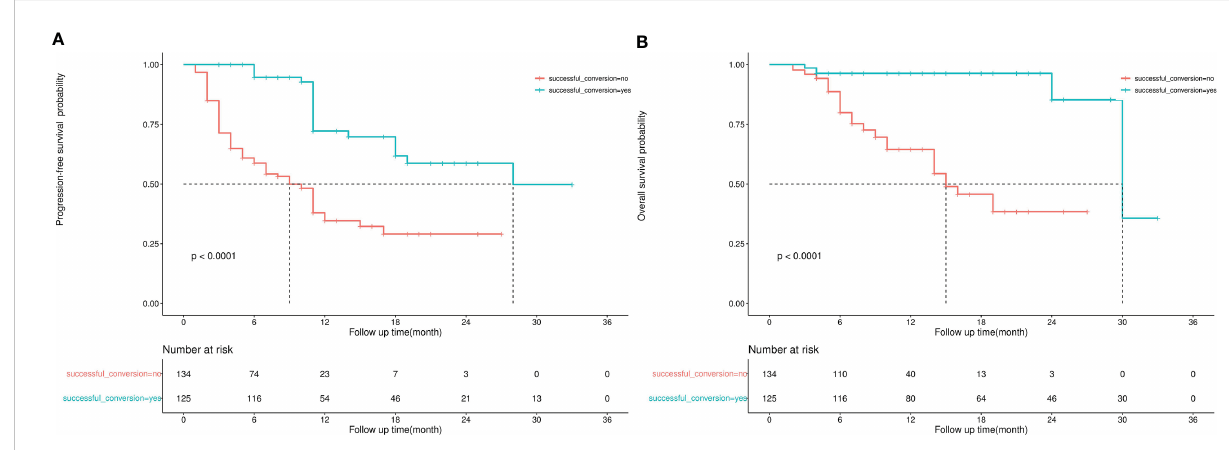
FIGURE 7 (A) IPW-adjusted Kaplan – Meier curve for PFS, (B) IPW-adjusted Kaplan – Meier curve for